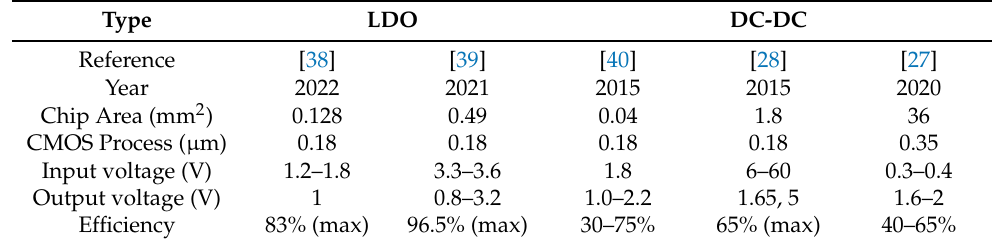
Table 2. The comparison of on-chip DC-DC and LDO as the secondary side voltage regulator. Type LDO DC-DC Reference [38]